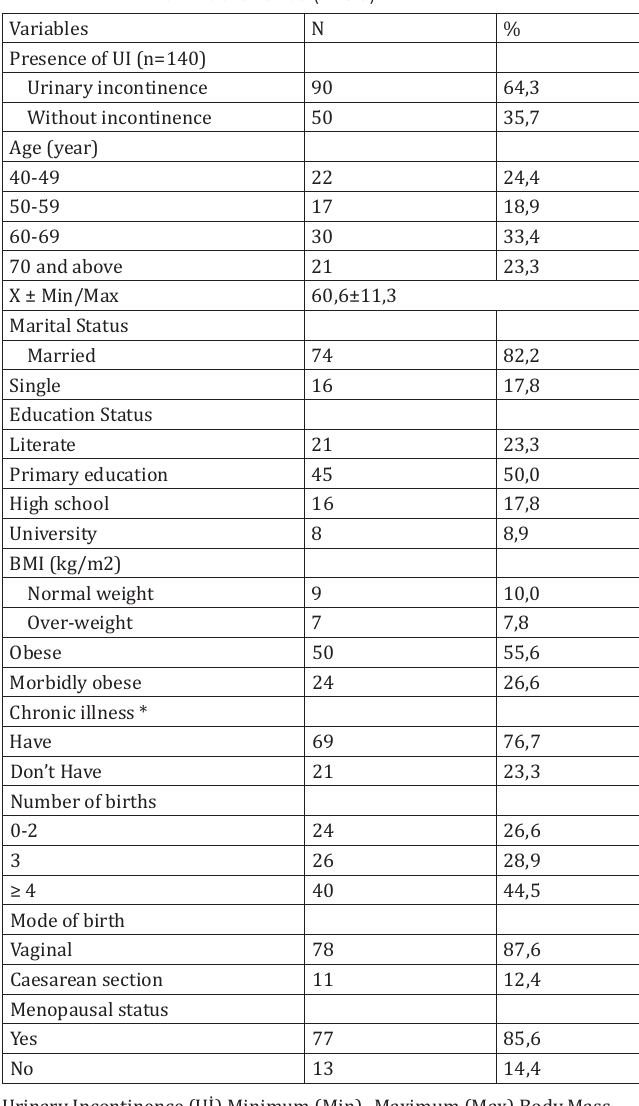
Introductory characteristics of women, chronic disease status, obstetrics and gynecological characteristics (n=90)